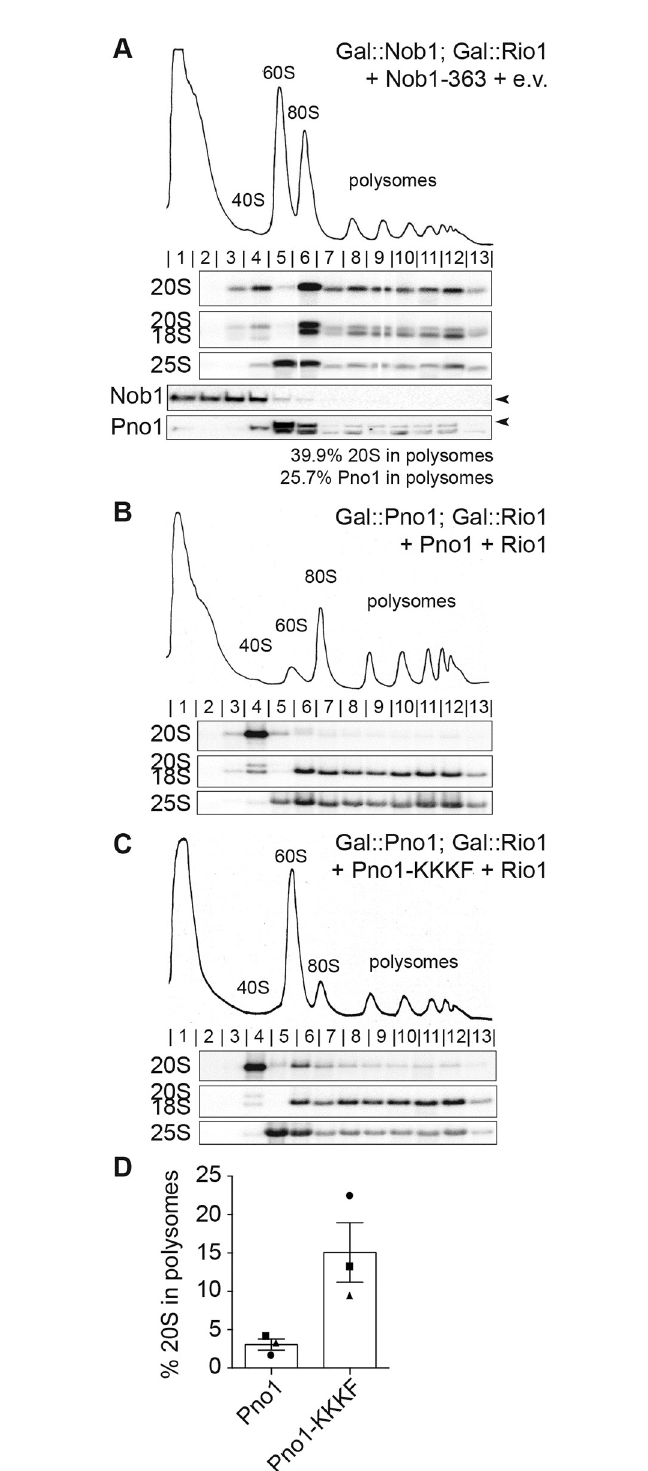
Fig 5. Rio1-mediated quality control ensures only mature 40S are released into the translating pool. (A) Sucrose gradients analyzed by northern and western blot of lysate from Gal::Nob1; Gal::Rio1 cells expressing the Nob1-363 truncated protein on a plasmid and grown in glucose for 16 h. Arrowheads note the bands corresponding to Nob1 and Pno1. The percentage of 20S pre-rRNA and Pno1 in polysomes (fractions 8–13) compared with total 20S pre-rRNA or Pno1 was calculated and listed below the western blot. Lane 5 was omitted from the Pno1 calculations because